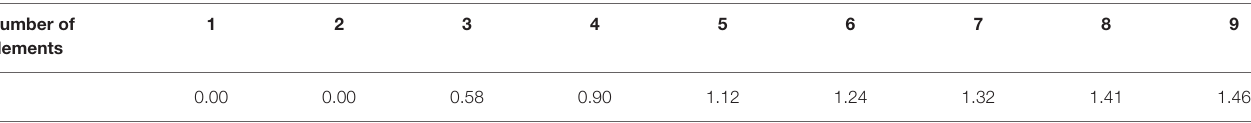
TABLE 15 | RI value of partial random consistency